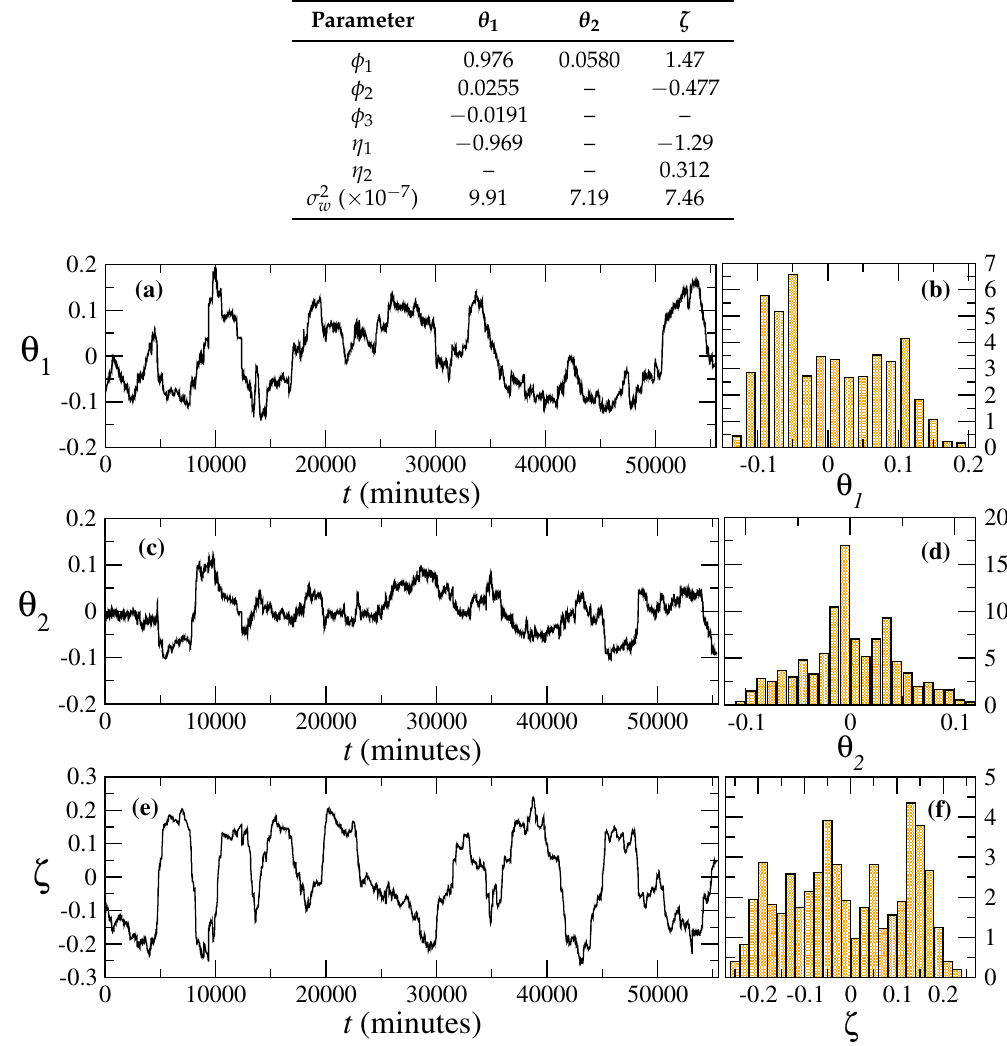
Table 2. Estimated coefficients entering Equations (12a)–(12c) of the ARIMA processes describing the stochastic evolution of the coefficients in Equations (11) and (13). Notice that each coefficient is modelled with an ARIMA process of different order: ARIMA ( 3,1, 1 ) for θ 1 , ARIMA ( 1,1, 0 ) for θ 2 , and ARIMA ( 2,1,2 ) for ζ .